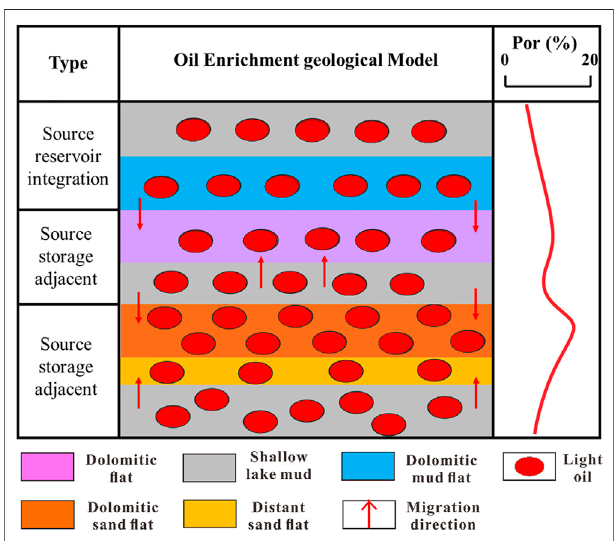
FIGURE 15 | Oil enrichment geological model of the Lucaogou Formation, Western Jimusar sag.